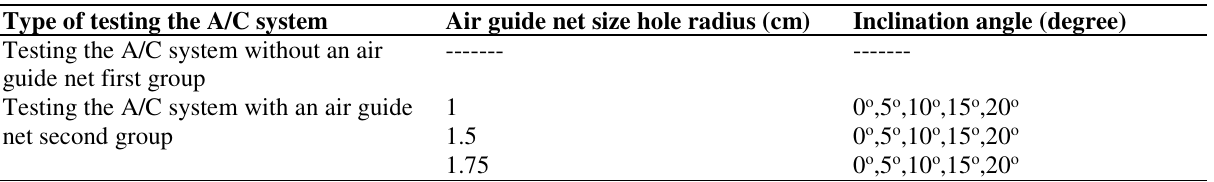
A brief outline of the experimental